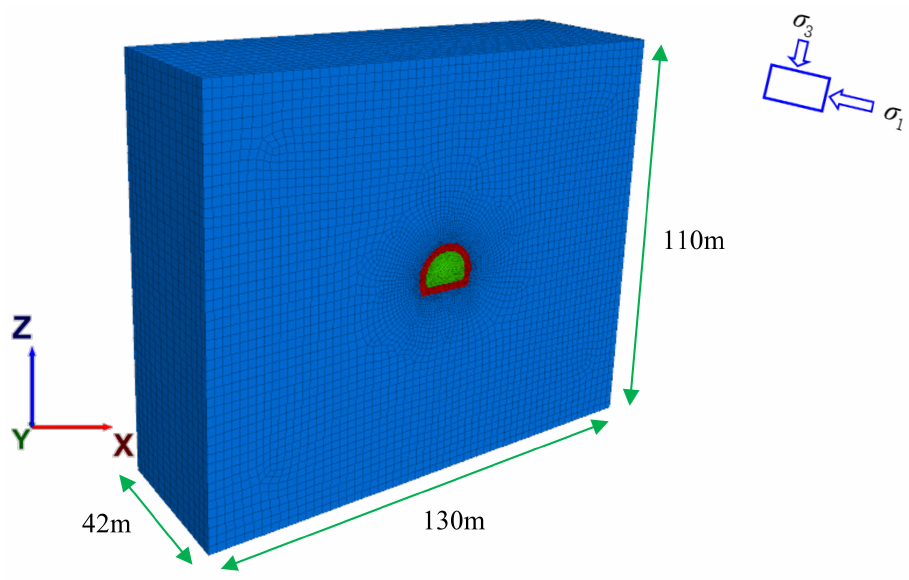
Figure 11. Tunnel calculation